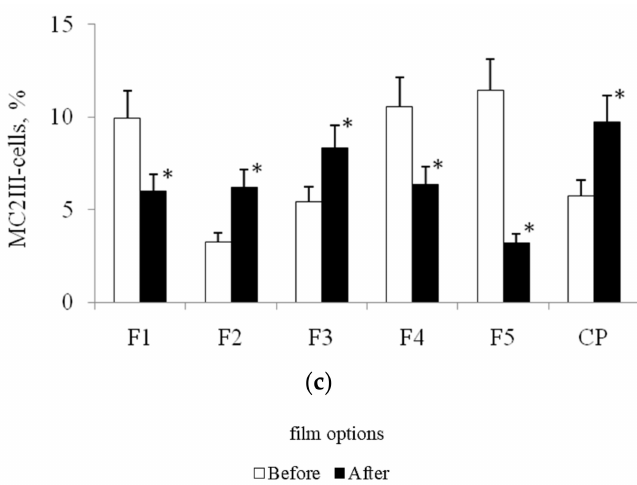
Figure 4. Quantity of cell by morphotypes in MC2 MPhs on PHA-samples before (Before) and after stenting (After).MC2I—filiform cells ( a ), MC2II—spindle-shaped cells ( b ), MC2III—rod-shaped cells ( c ). CP—cultural plastic. F1–F5—PHAs-films. * —values for the variant after stenting, significantly di ff erent from the variant before stenting ( p < 0.05).